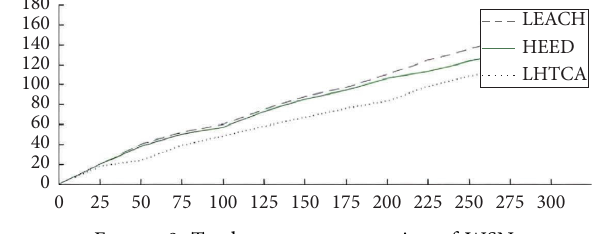
Figure 9: Total energy consumption of